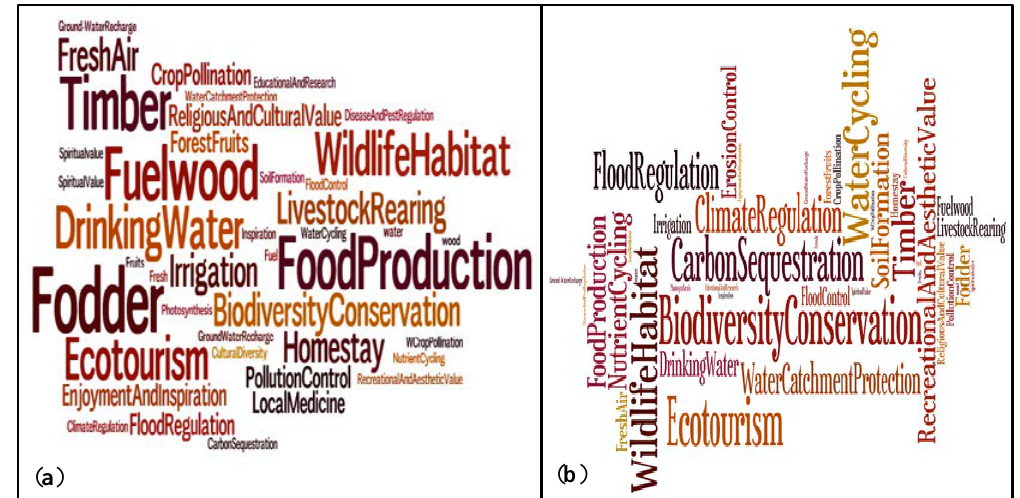
Figure 3. Prioritization of ES by Forest Users—Figure ( a ); and Forest Managers—Figure ( b ) in the PMER, Nepal. The word size indicates the priority of respective ES—the larger the font size, the higher the priority by the respondents.